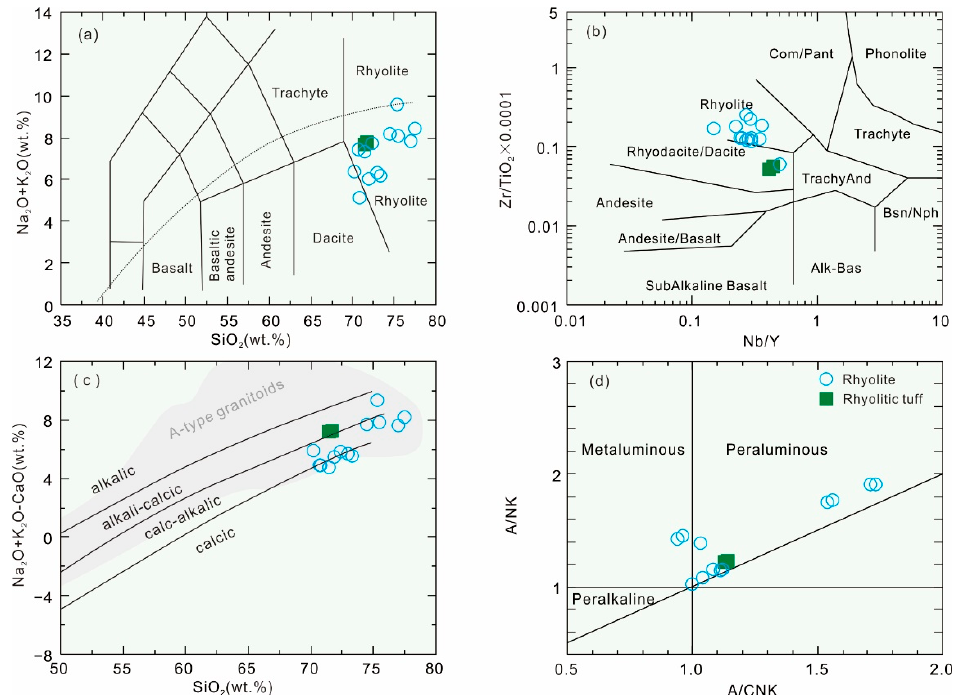
Figure 6. Geochemical diagrams for the Early Devonian volcanic rocks from Haerdaban area in the northern margin of Yili Block. ( a ) Total alkalis versus SiO 2 diagram (reference line after [46]). ( b ) Zr/TiO 2 versus Nb/Y diagram (reference lines after [47]). ( c ) Na 2 O + K 2 O-CaO versus SiO 2 diagram (reference lines and fields after [48]). ( d ) Plot of A/NK versus A/CNK (reference lines and fields after [49]).